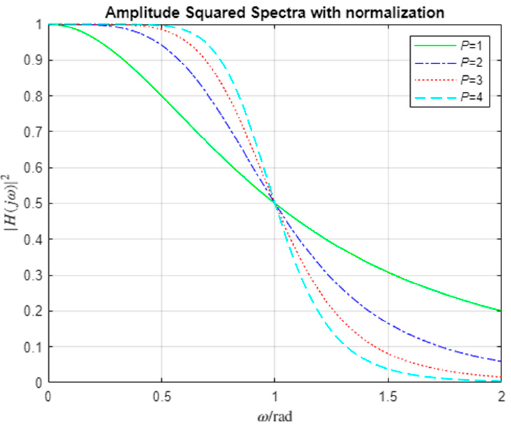
Figure 1. Amplitude Spectra of different order 𝑃 with normalization. Table 1. Coefficient of the lowpass Butterworth filter in the model (7).